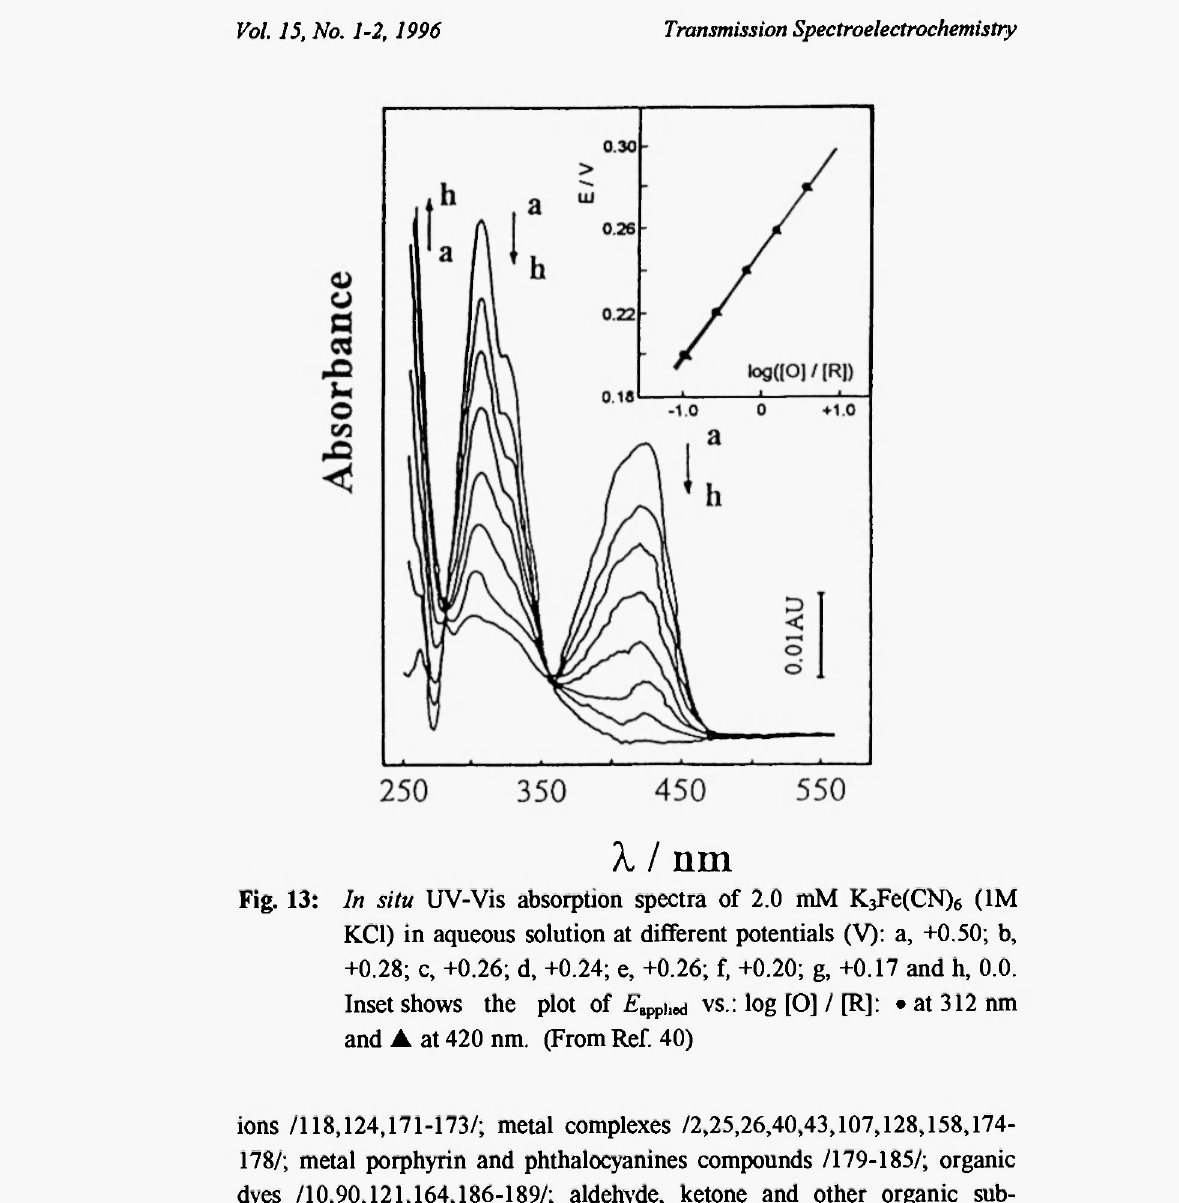
ions /118,124,171-173/; metal complexes /2,25,26,40,43,107,128,158,174- 178/; metal porphyrin and phthalocyanines compounds /179-185/; organic dyes /10,90,121,164,186-189/; aldehyde, ketone and other organic sub- stances /23,24,68,89,119,190-194/; biological molecules /6,15-18,40,195- 198/, as well as enzyme and protein molecules /2,10,45,38,93,94,157,